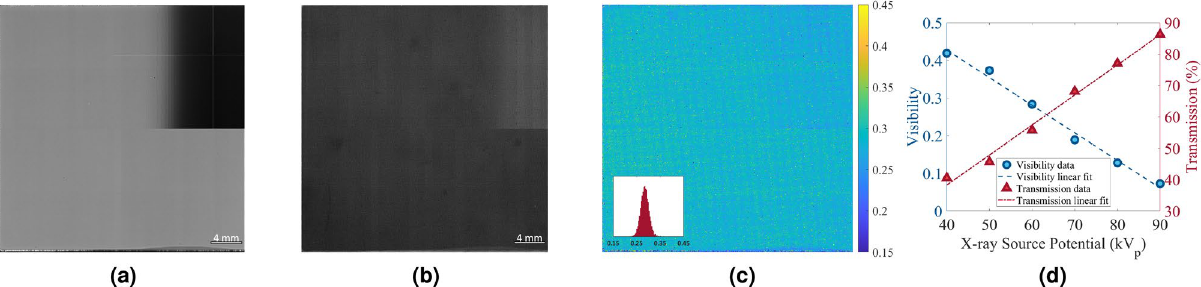
Figure 10. ( a ) Gain map of the prototype 4K × 4K high-resolution X-ray detector, showing detector defects and artifacts; the top right quarter of the detector is defective. ( b ) Transmission image for part of the prototype fabricated grating at 60kV p . ( c ) Visibility map for the prototype fabricated grating. ( d ) Visibility and transmission profiles versus X-ray source